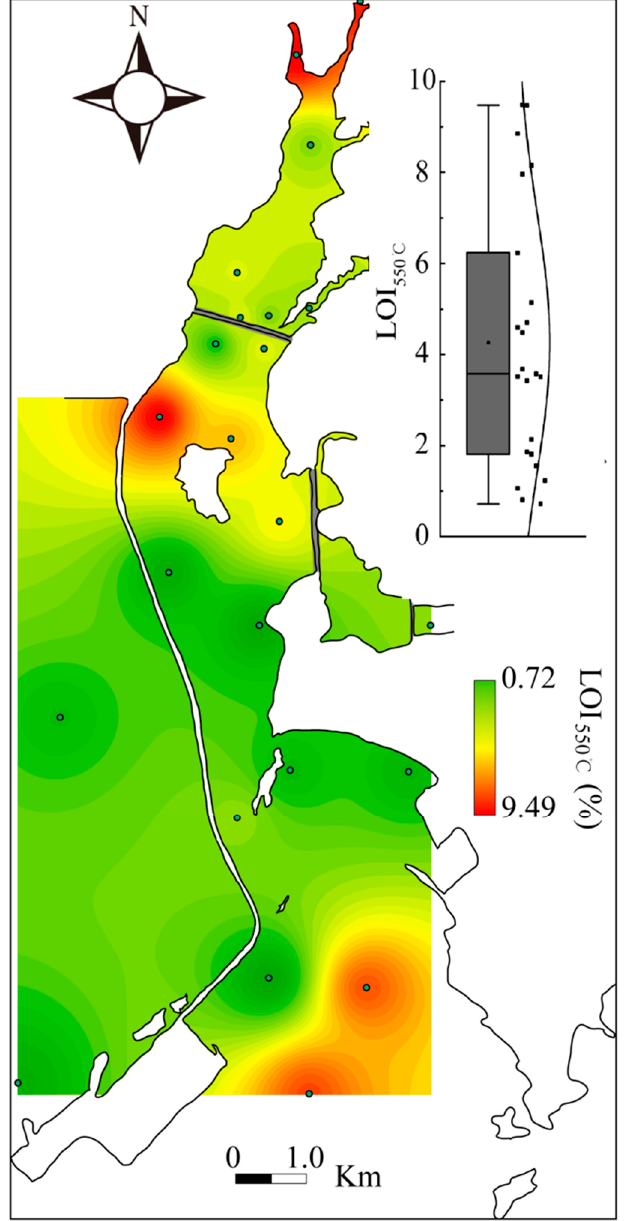
Figure 8. Organic matter content and its spatial distribution of 24 sediment samples in the Lu’erhuan River Sea area of Qinzhou Bay, Guangxi Province.